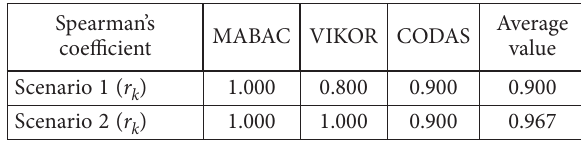
Table 13. The rank correlation of the models